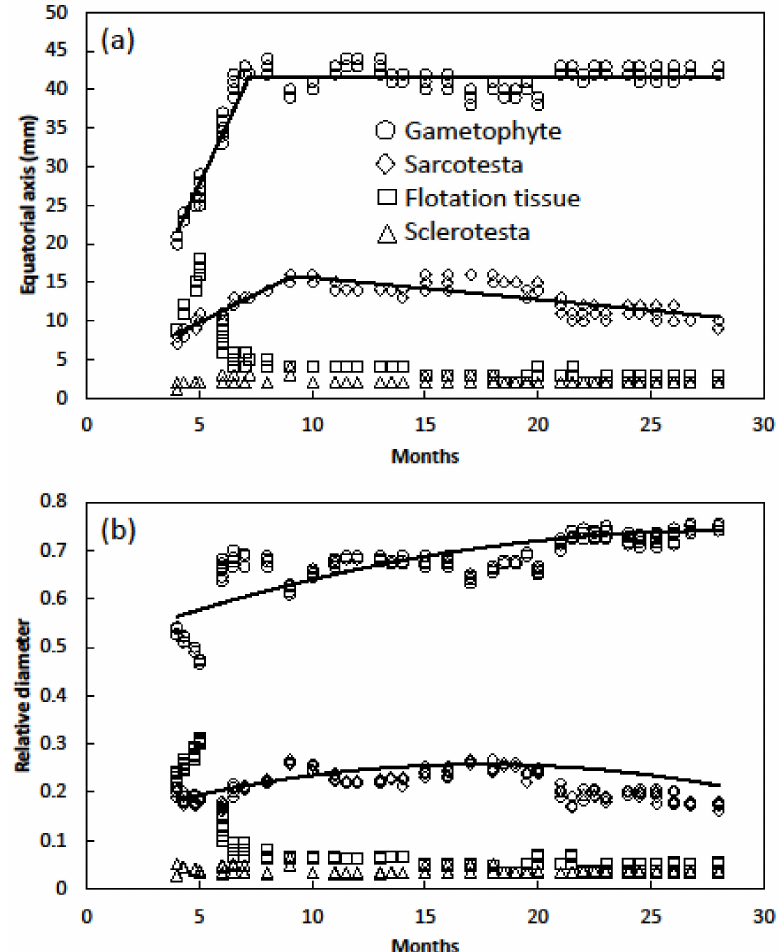
Figure 6. Equatorial diameter of Cycas micronesica seed tissue categories from 4 to 28 months